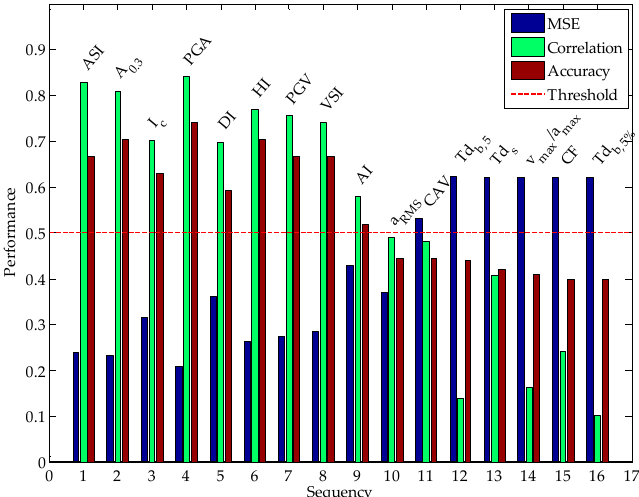
Figure 6. Performance of SVR with a sole feature for the 16 ground motion parameters.